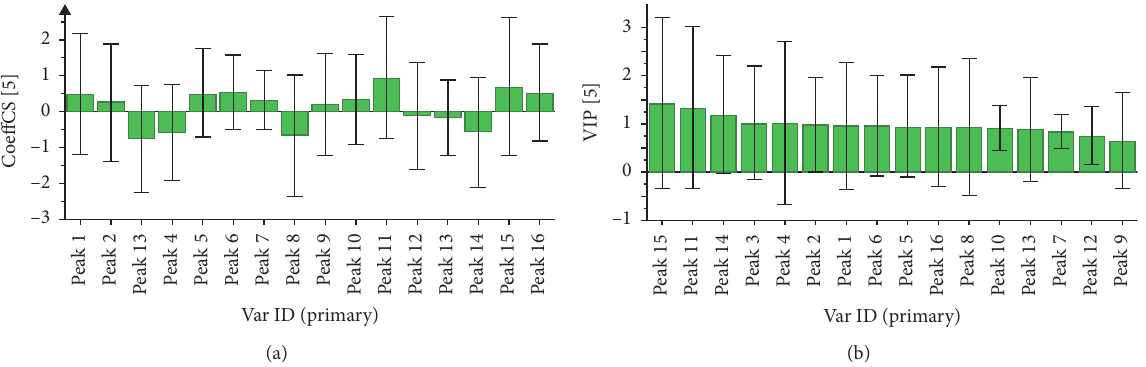
Figure 5: Correlation analysis between common peak area of the AMR and its inhibition rate of tyrosinase activity. (a) Normalized regression coefficient diagram. (b) VIP values.